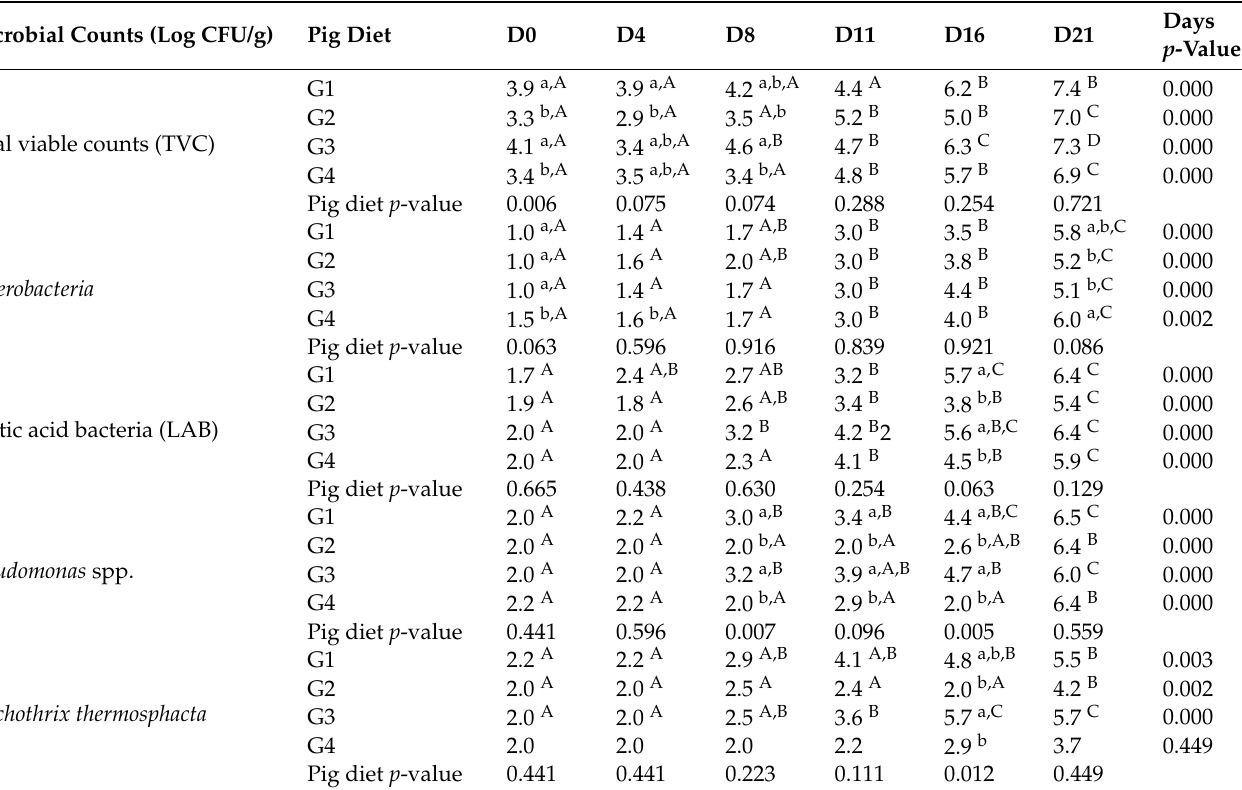
Table 8. Microbial counts of pig meat from dietary experimental groups packaged in a modified atmosphere throughout the storage (0, 4, 8, 11, 16 and 21 days) in commercial display